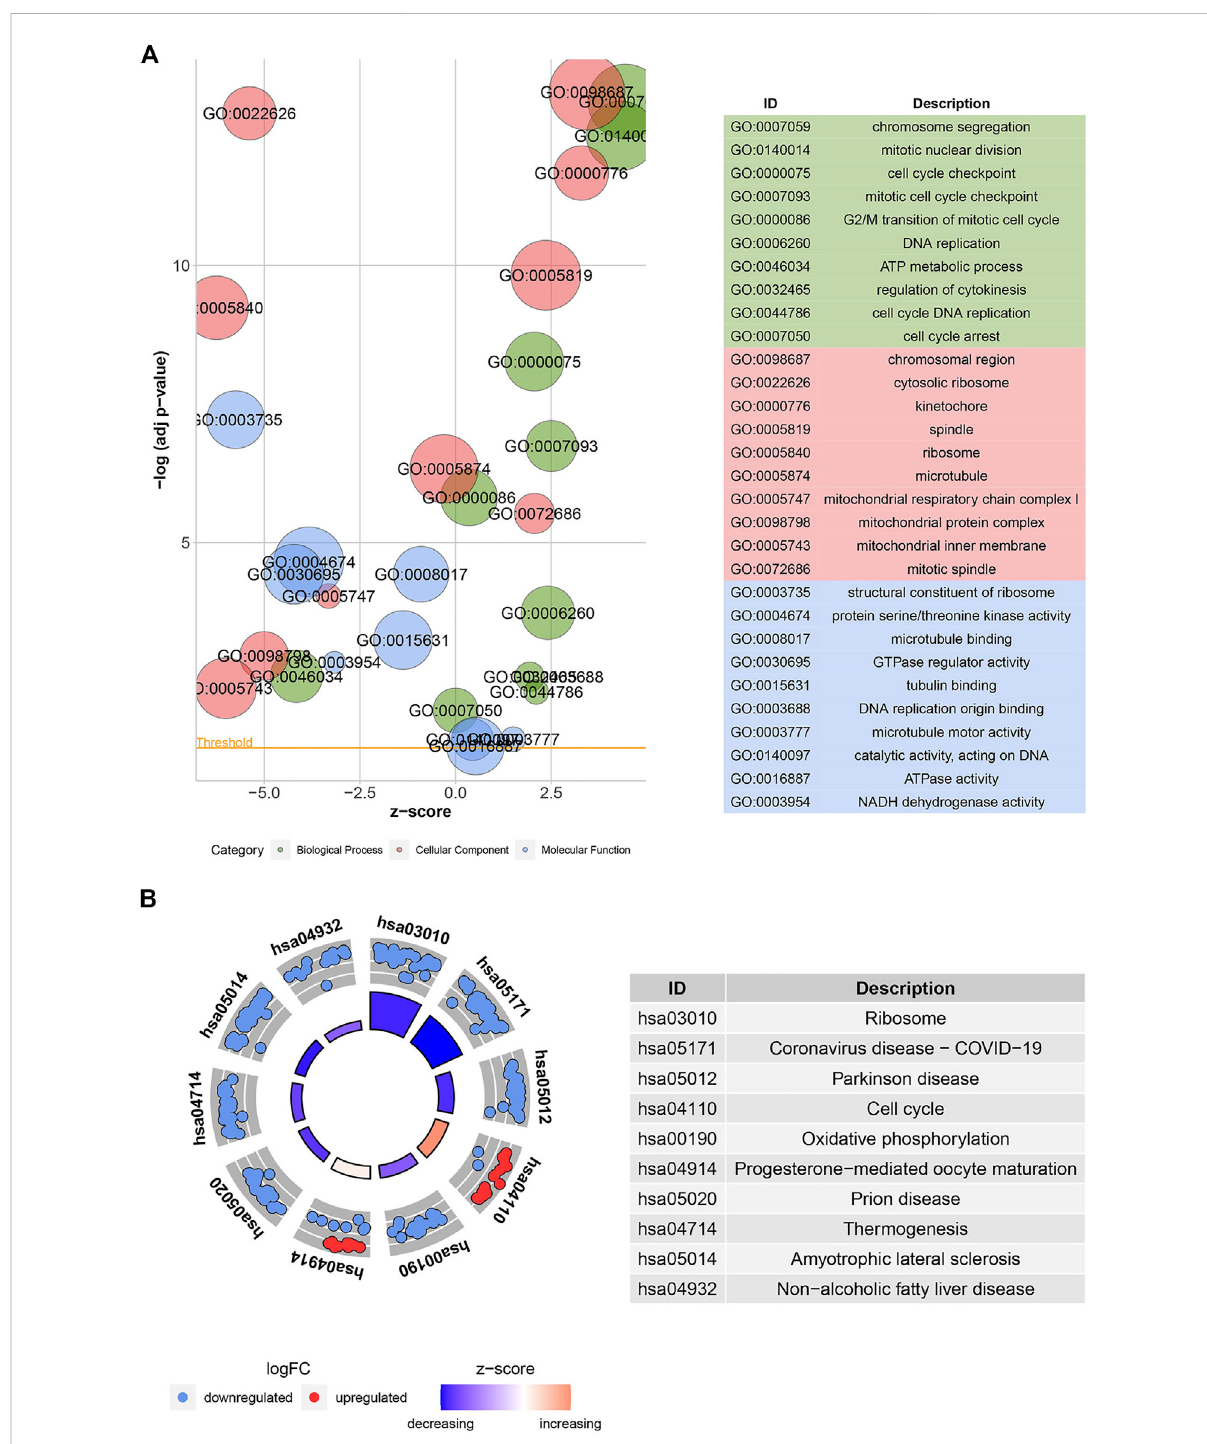
FIGURE 3 Gene ontology (GO) and Kyoto encyclopedia of genes and genomes (KEGG) enrichment analyses. Bubble plot (A) shows the GO function analysis for the 904 common DEGs. The circle plot (B) shows the KEGG pathway analysis for the common DEGs. The higher the z-score, the higher the expression of enriched